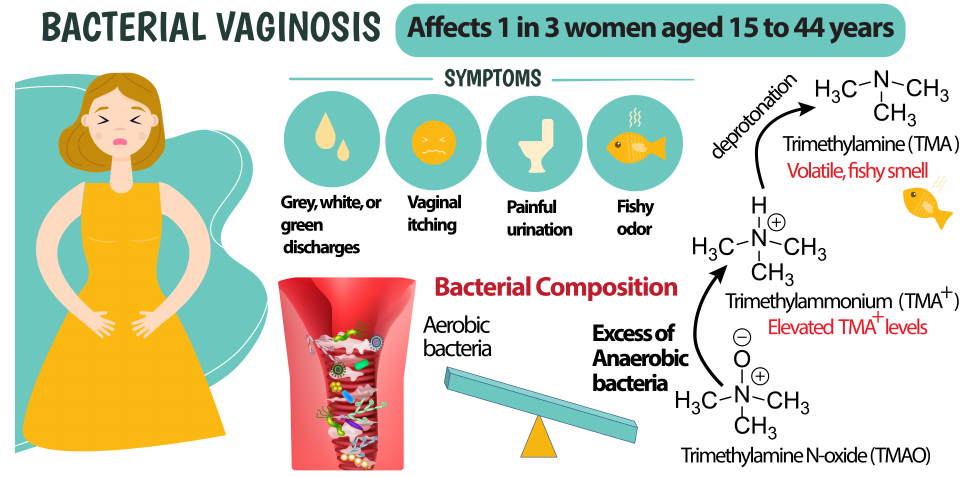
Figure 1. Bacterial vaginosis symptoms and TMA production mechanism. A reduction in TMAO caused by anaerobic bacteria results in elevation of TMA levels in vaginal